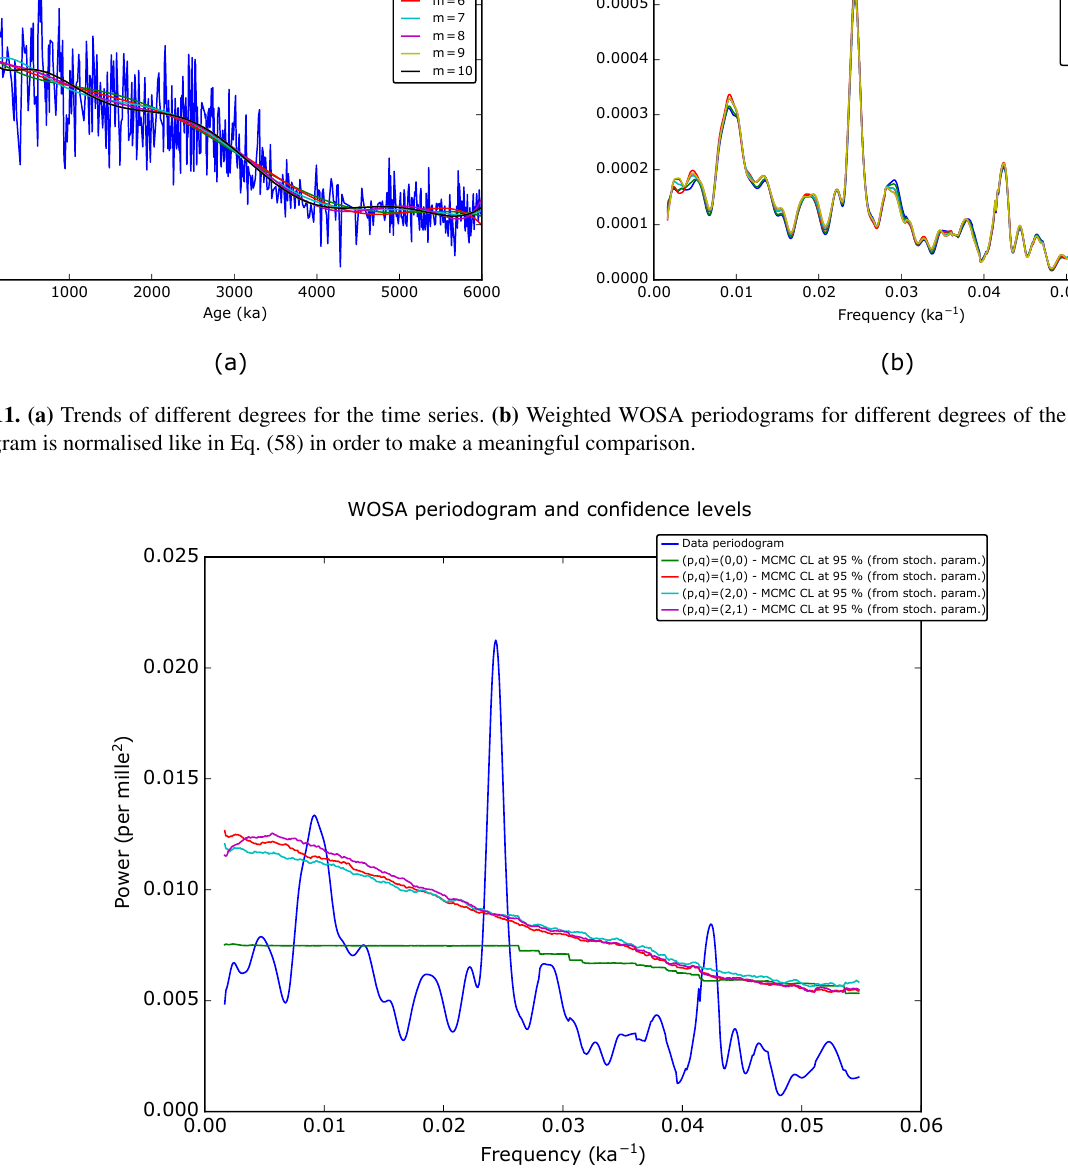
Figure 12. The weighted WOSA periodogram and its 95% confidence levels for different orders ( p,q ) of the CARMA process. Note that the marginal posterior distributions of some parameters of the CARMA(2,0) and CARMA(2,1) processes are multimodal, so the analytical approach cannot be applied, and MCMC confidence levels must therefore be